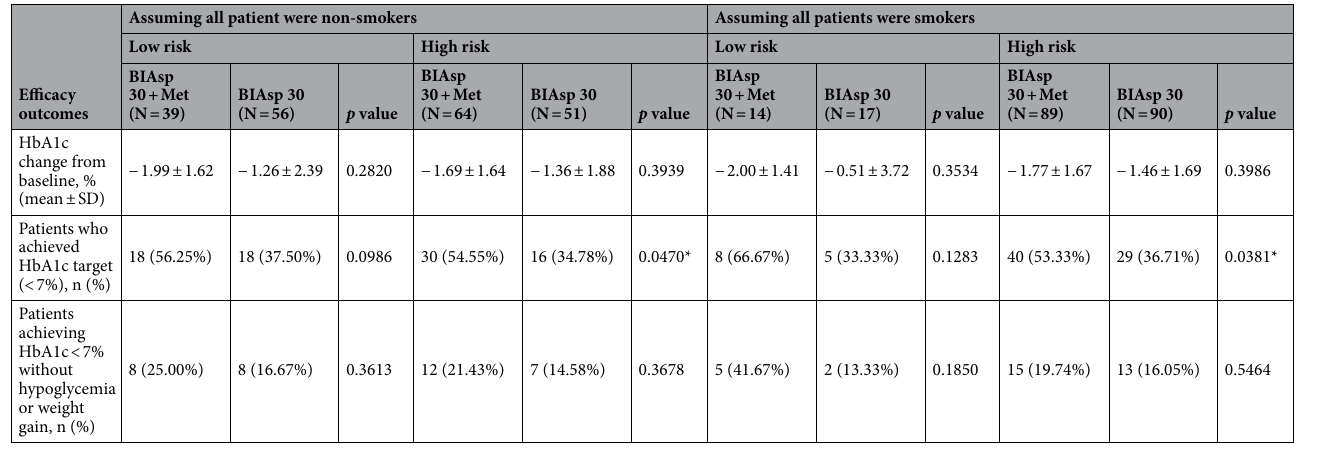
Table 1. Efficacy outcomes in patients with low (< 20%) and high (≥ 20%) 10-year risk of cardiovascular disease receiving biphasic insulin aspart 30 (BIAsp 30) and metformin combination therapy or BIAsp